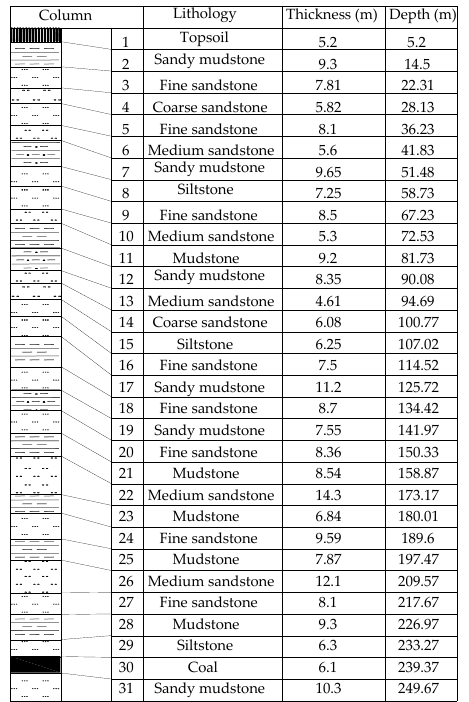
Figure 5. Location of Sihe coal mine, Jincheng City, Shanxi Province, China.